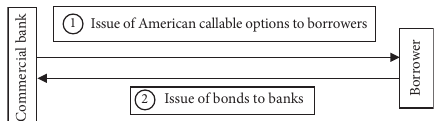
Figure 1: The decomposition of bank loan with embedded option.